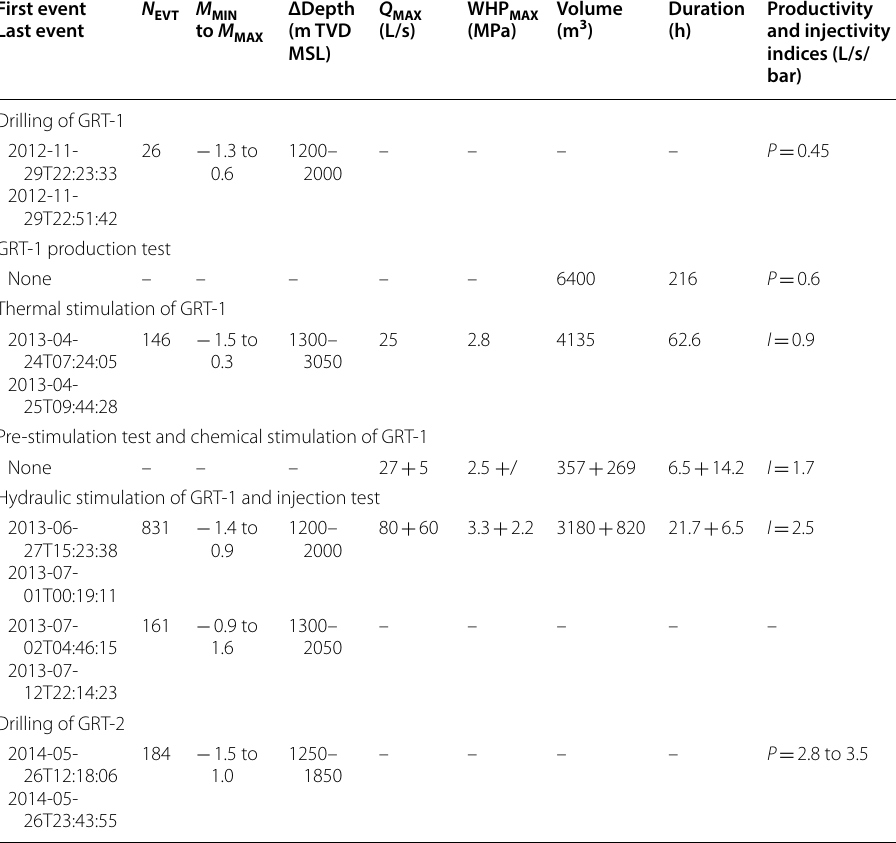
Table 2 Summary of the seismicity observed during the development of the Rittershoffen geothermal